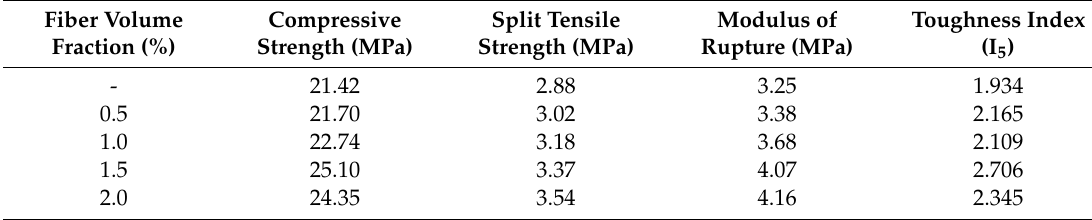
Table 1. Comparison of PC and CFRC mechanical properties according to Baruah and Talukdar